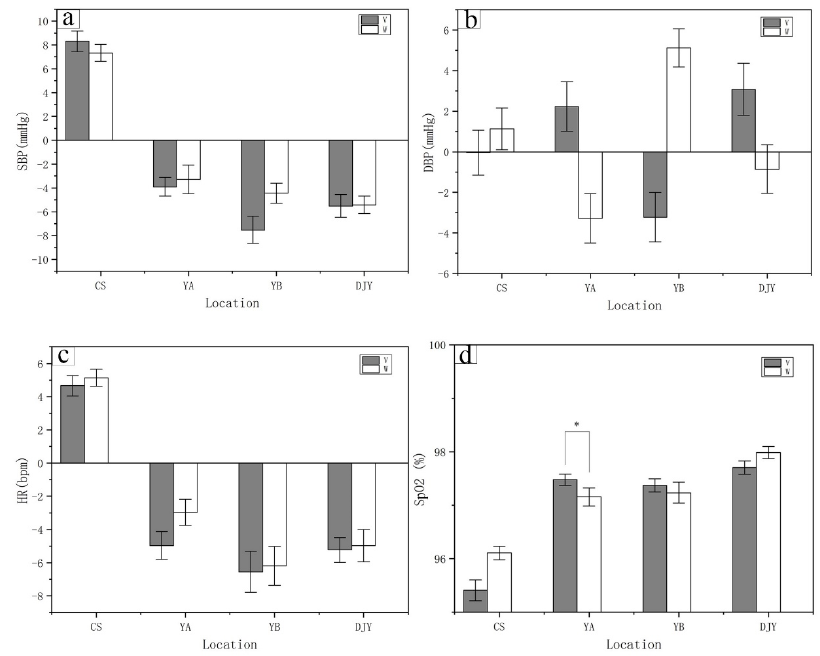
Figure 6. Systolic blood pressure, diastolic blood pressure, heart rate, and peripheral oxygen saturation in participants after bamboo forest and urban program. A paired t -test was used to compare the data between viewing and walking activities after three days of bamboo forest therapy. The data are presented as the mean ± SEs; * p < 0.05; significant di ff erence between the data for viewing and walking activities was observed for the physiological indexes by paired t test. CS ( n = 30), City site; YA ( n = 30), Ya’an sites. YB ( n = 30), Yibin sites. DJY ( n = 30), Dujiangyan sites. ( a ) SBP, systolic blood pressure; ( b ) DBP, diastolic blood pressure; ( c ) HR, heart rate; ( d ) SpO2, peripheral oxygen